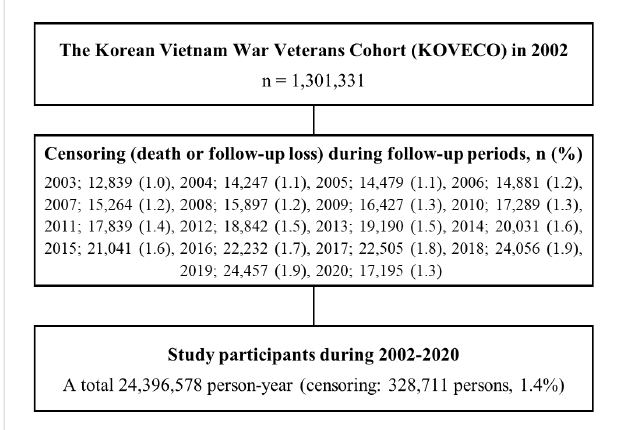
FIGURE 1 Detailed fl ow diagram of the study